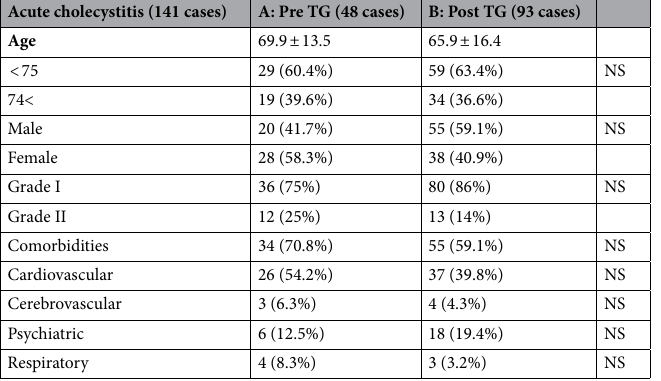
Table 1. Patient characteristics. 141 patients were examined divided into two groups A; before guideline introduced: 48 cases, B; after the introduction: 93 cases. No patient had Grade III disease. More than 50% of patients had comorbidities, especially cardiovascular